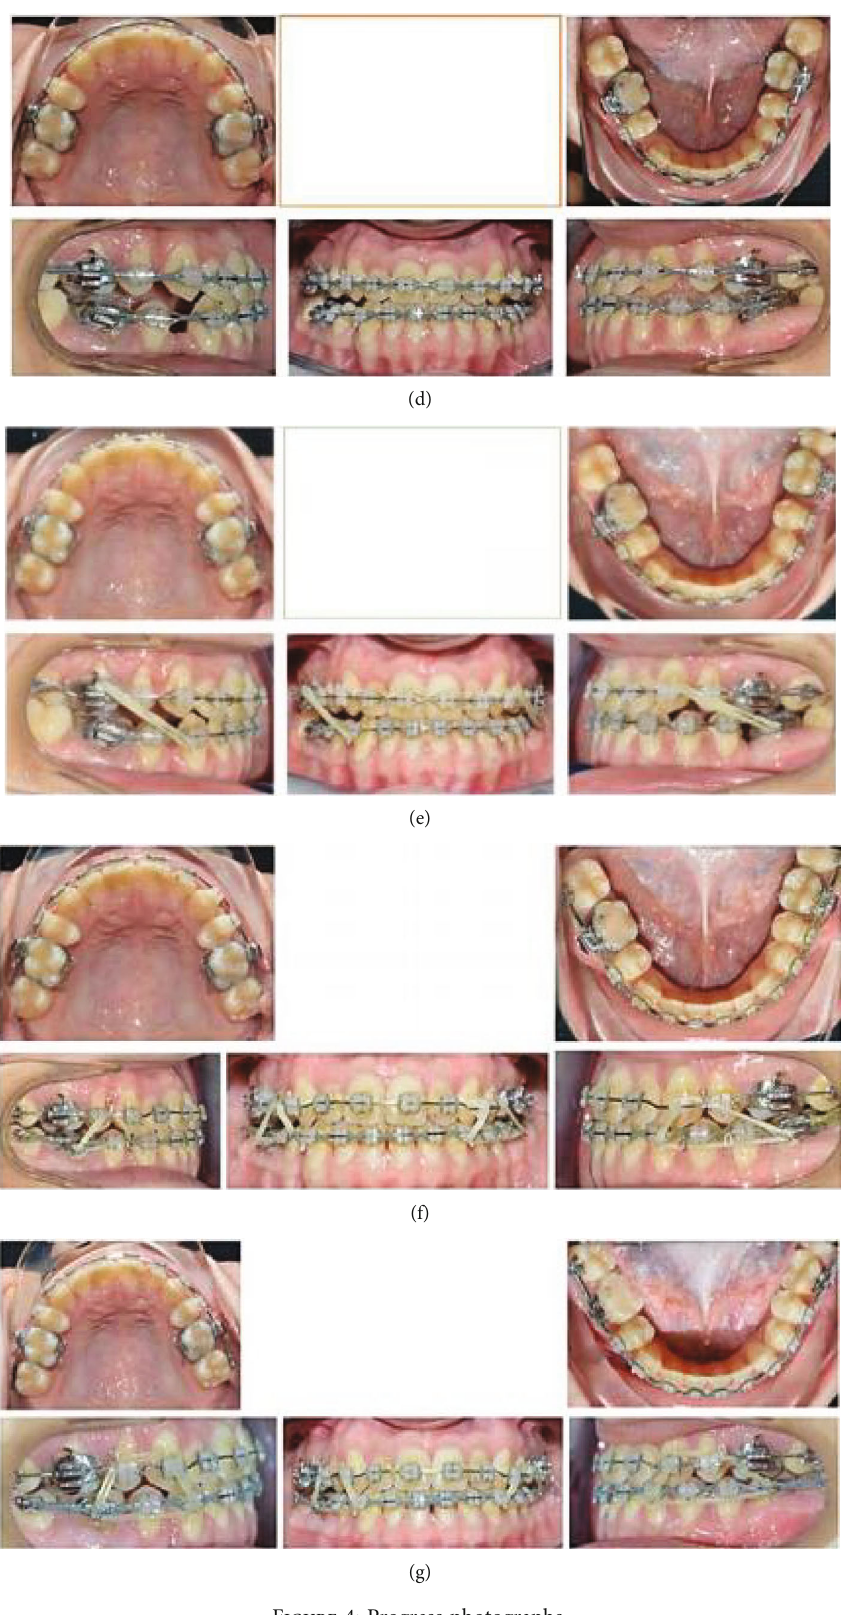
Figure 4: Progress